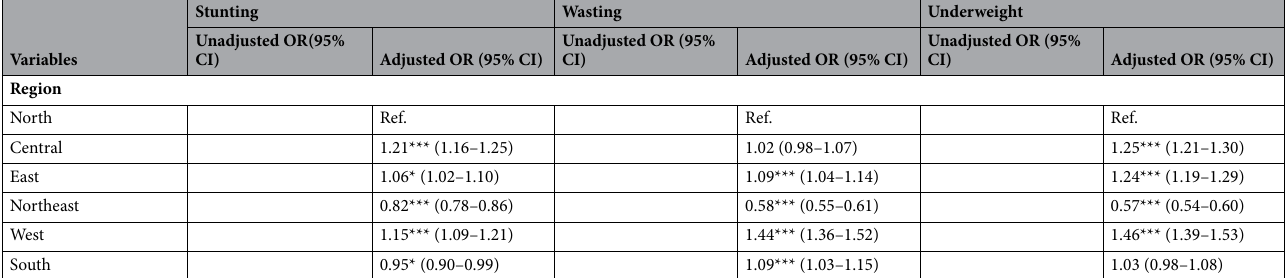
Table 4. Unadjusted and adjusted odds ratios using logistic regression models investigating the relationship between mothers’ high-risk births behaviour and children’s nutrition outcomes, India, (NFHS-4). OR: Odds Ratio, CI: Confidence Interval. Significant level: *** p < 0.001, ** p < 0.01, * p < 0.05